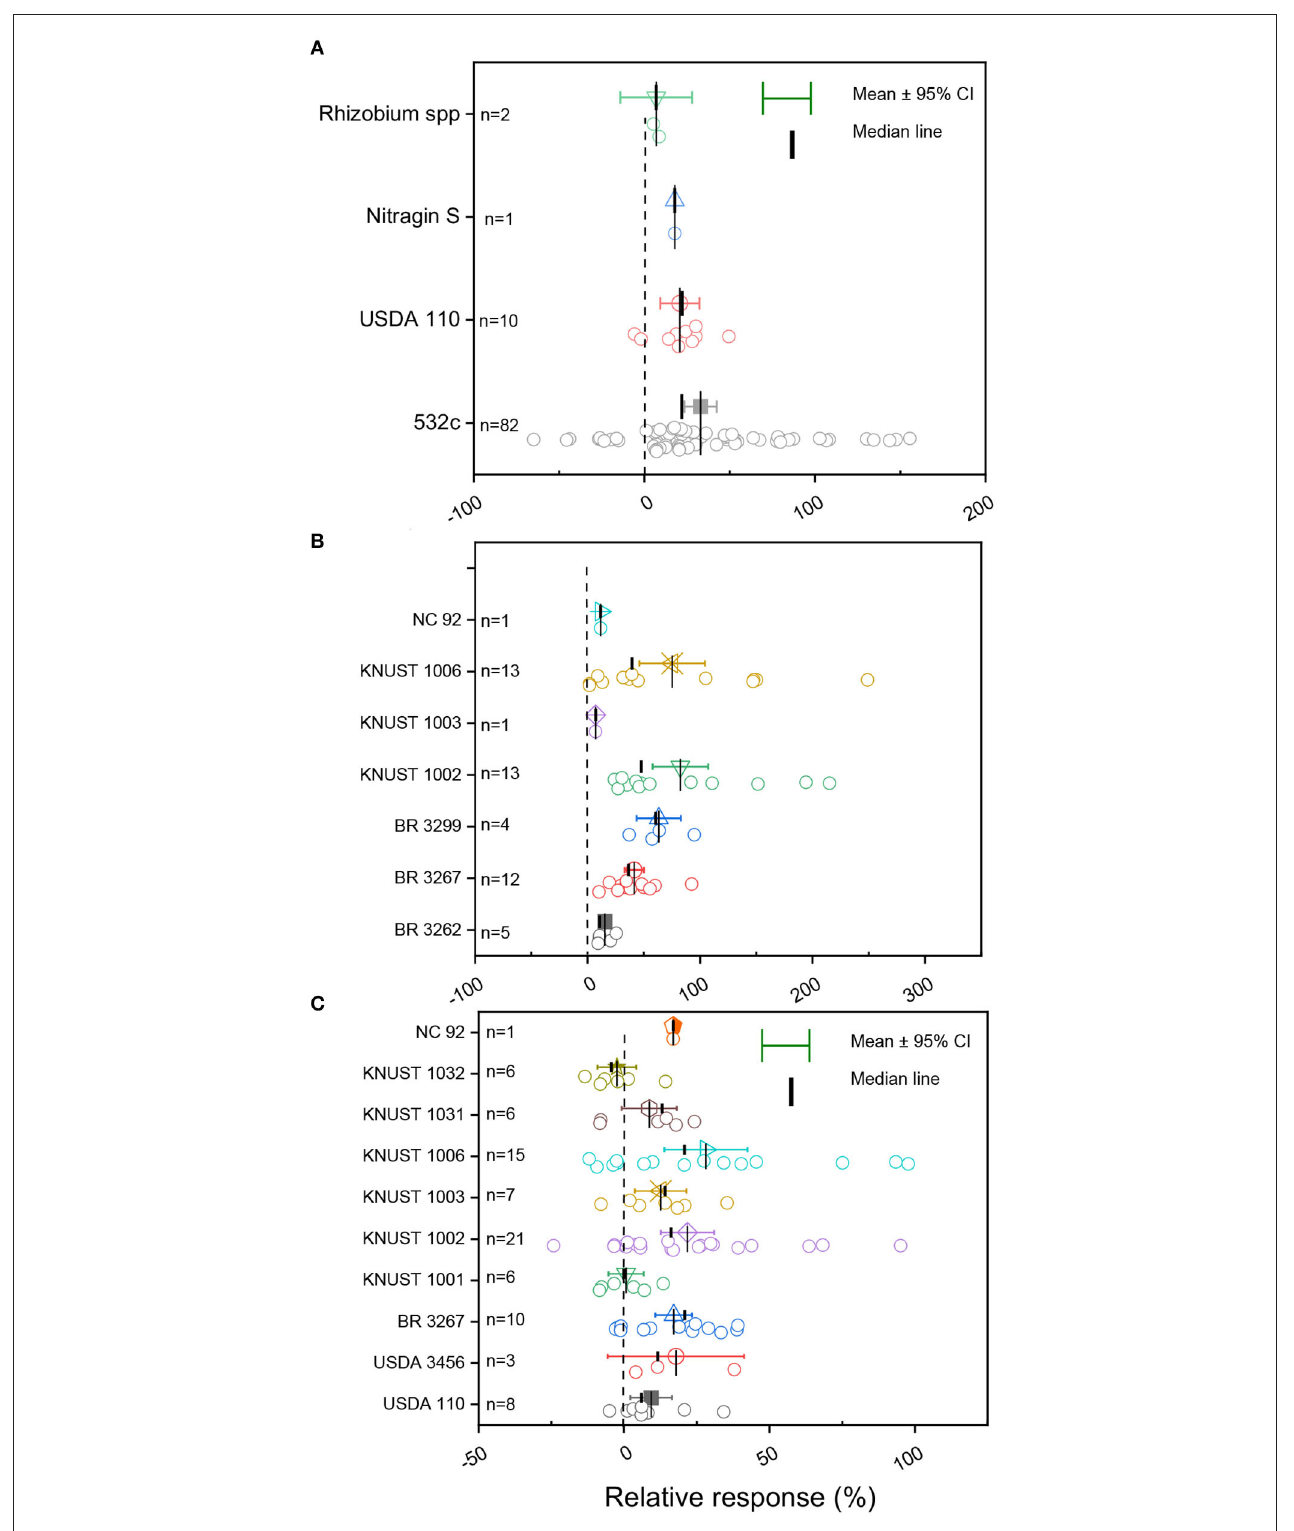
FIGURE 4 | Boxplot and scatter data (open circle symbol) of the relative increase in grain yield following inoculation with diverse rhizobia strains for (A) soybean, (B) cowpea, and (C) groundnut compared to the uninoculated control plants under Ghanian soil. The mean values (different symbols) with a 95% bootstrap confidence interval, the median line, and the sample size are